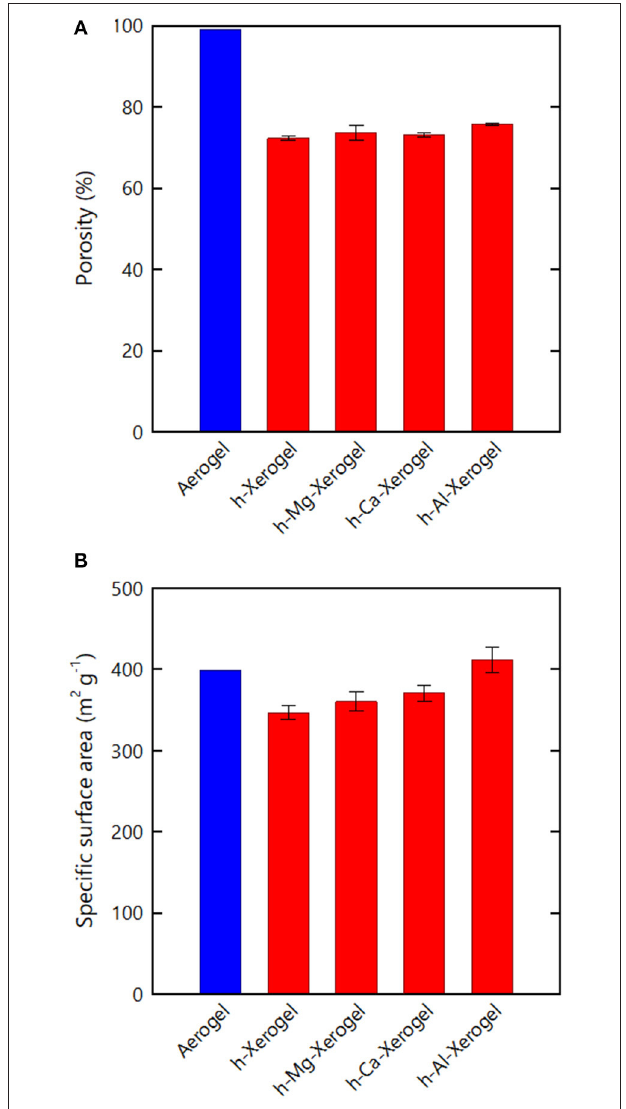
FIGURE 5 | (A) Porosity and (B) SSA values estimated from the nitrogen adsorption–desorption isotherms of the respective